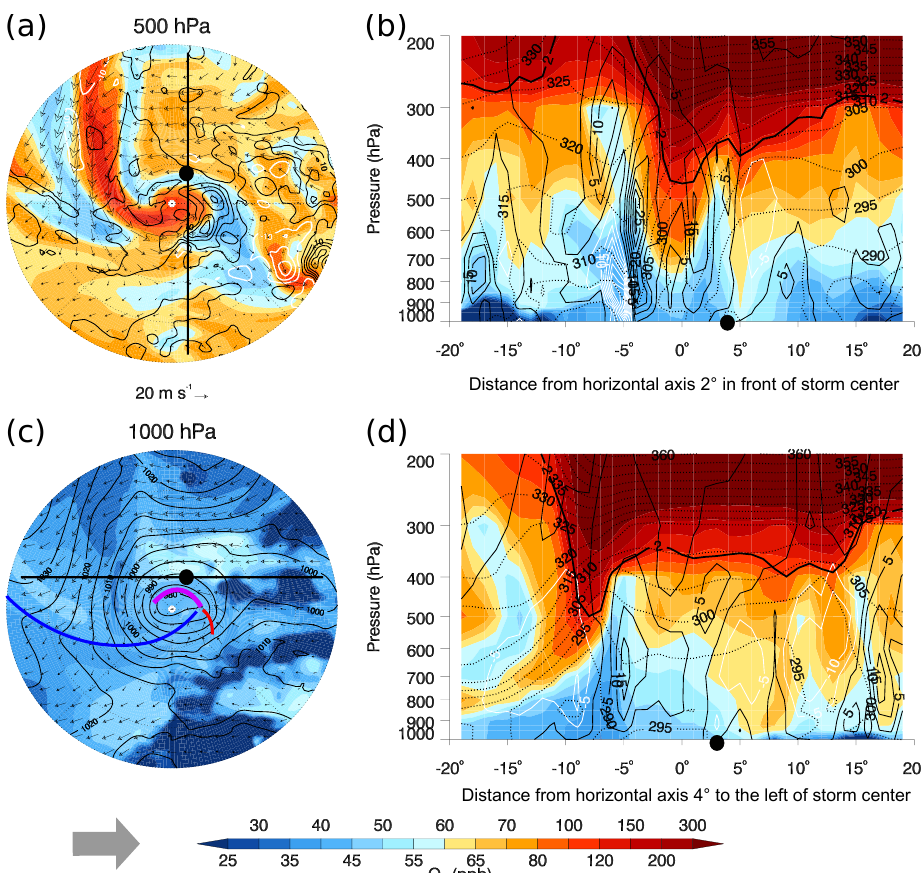
Figure 10. Similar to N1 cyclone Figs. 6 and 7 except for the S1 cyclone on 25 April 2012 at 00:00UTC (see Fig. 8). The approximate location of the occluded (purple line), warm (red line), and cold (blue line) fronts in (c) are based on the fronts in Fig. S5a and the synoptic analysis chart (not shown). The additional thick vertical lines in (a) and (c) indicate the location of the vertical transects (b) 2 ◦ in front of the cyclone center and (d) 4 ◦ to the north of cyclone center, respectively. The cross sections have positive axis values to the north (a, b) and to the east (c, d) . The approximate location of Mace Head has been indicated by the large black dot. The cyclone has been rotated in order that the direction of cyclone propagation is toward the right, indicated by the grey